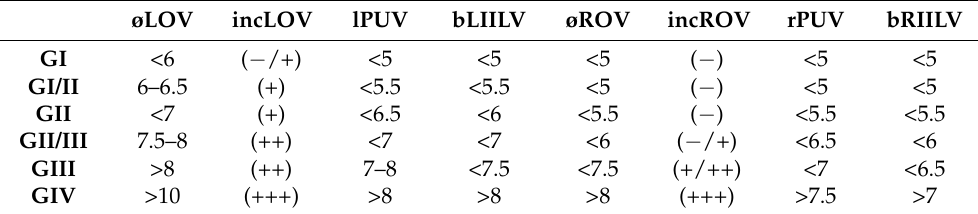
Table 4. Grades of ovarian veins insufficiency in pelvic venous incompetence. Acronyms: Ø LOV/ Ø ROV–diameter of left or right ovarian vein; incLOV/incROV–incompetence of left or right ovarian vein; lPUV/rPUV–left or right para-uterine veins; bLIILV/bRIILV–branches of left or right internal veins. All numeric values are in “mm”.